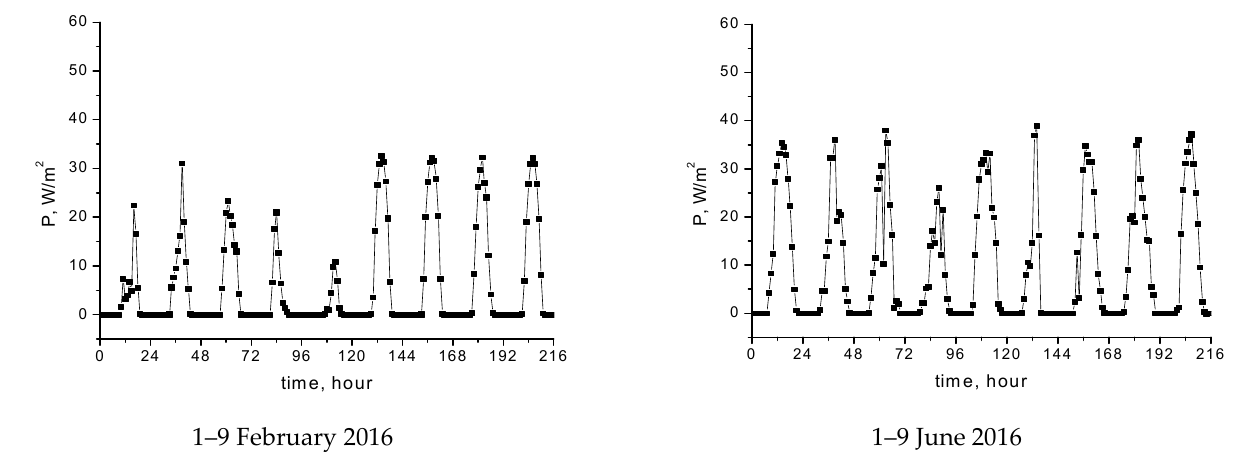
Figure 1. The daily production of specific power from solar energy conversion.